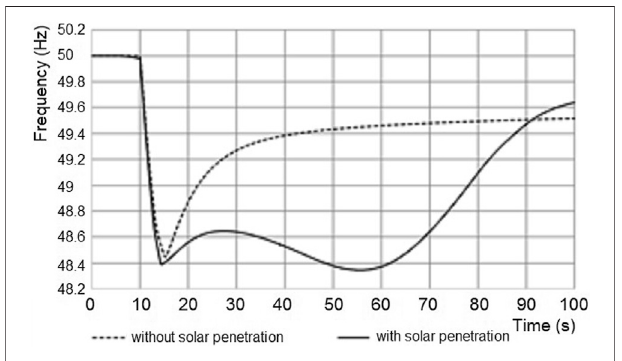
FIGURE 1 | Dynamic frequency